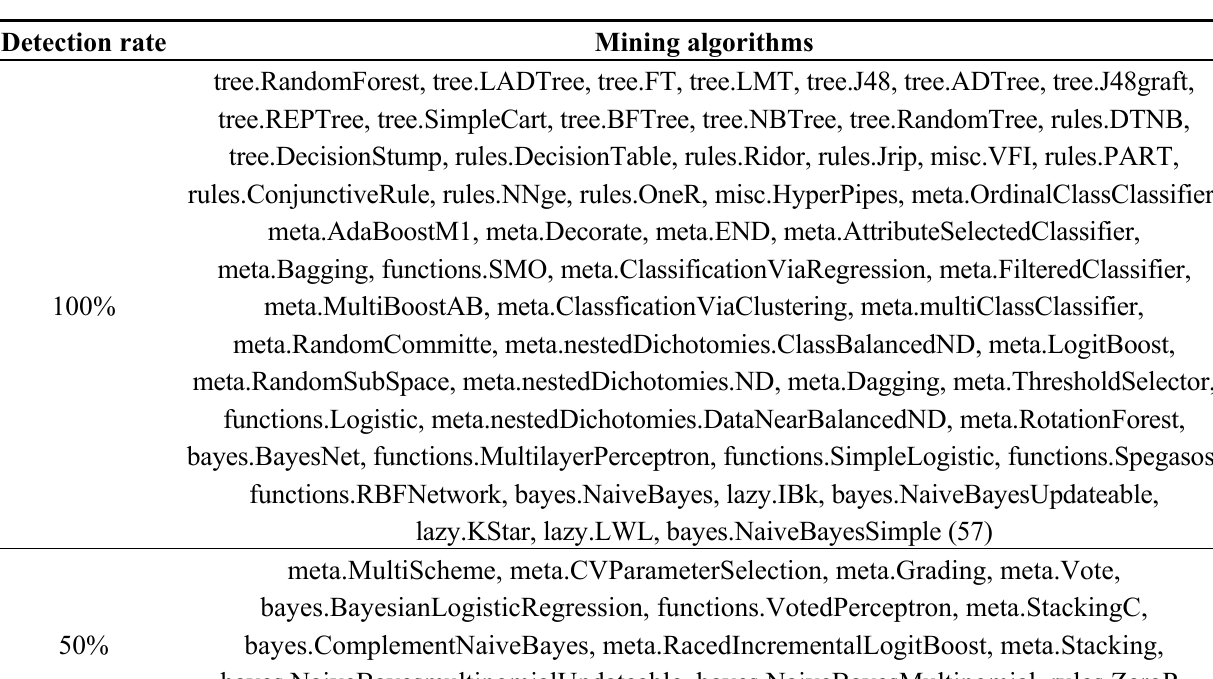
Table 5. Buffer overflow attack—mining results with ADTree, RandomTree, REPTree selection